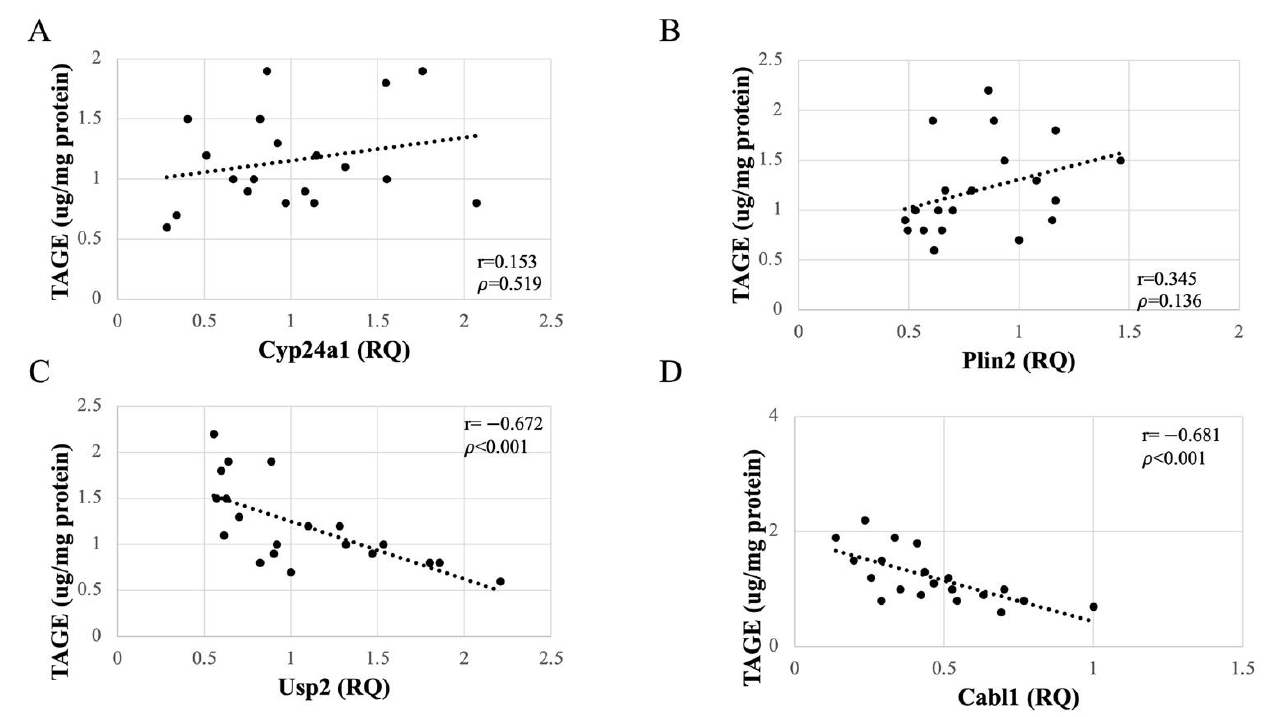
Figure 6. Relationships between intracellular toxic advanced glycation end-products (TAGE) levels in the liver of Wistar rats and expression of Cyp24a ( A ), Plin2 ( B ), Usp2 ( C ), and Calb1 ( D ) in the kidneys. RQ, relative quantification by real-time polymerase chain reaction ( n = 10 per group).